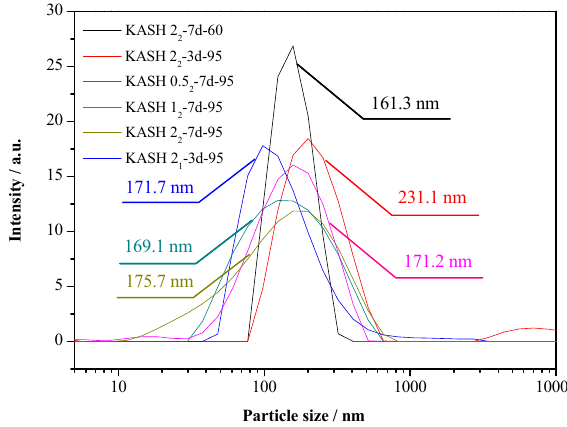
Figure 8. Particle size distribution of K-A-S-H samples.